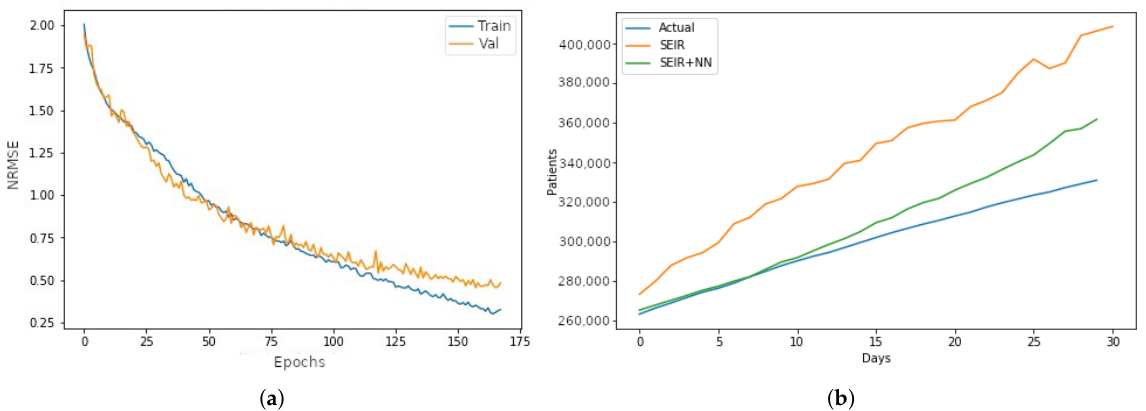
Figure 7. ( a ) NRMSE vs. epochs. ( b ) Confirmed cases comparison